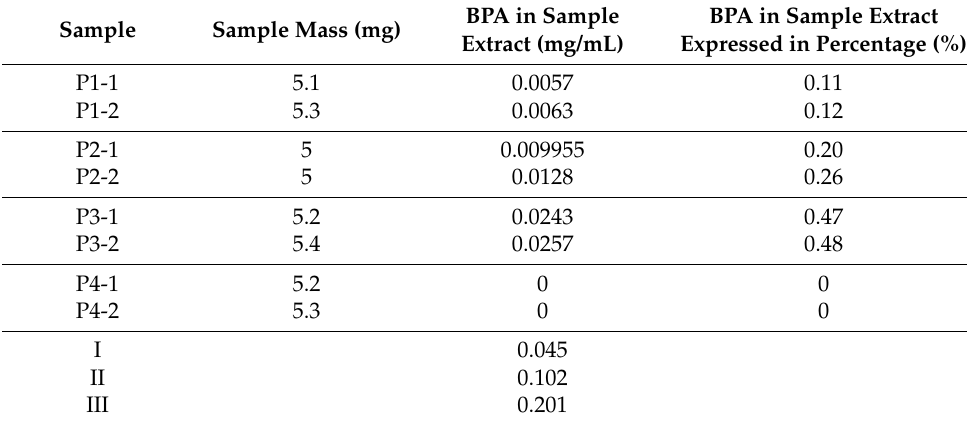
Table 1. BPA content in Lemna minor